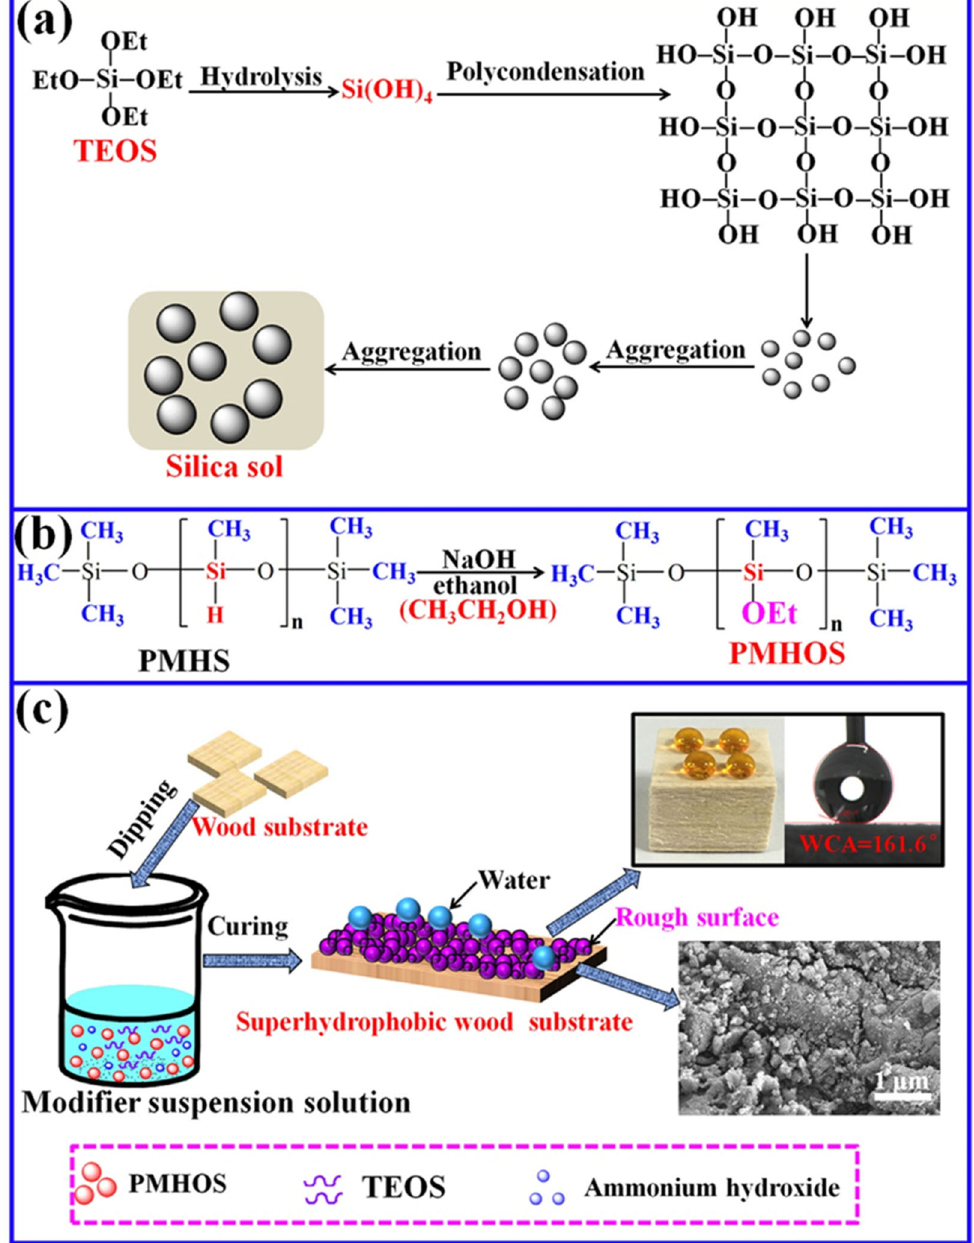
Figure 10. Schematic illustration of the formation mechanism of the superhydrophobic wood surface: ( a ) the formation process of silica sol; ( b ) the preparation mechanism of PMHOS powder; ( c ) the preparation of superhydrophobic wood.